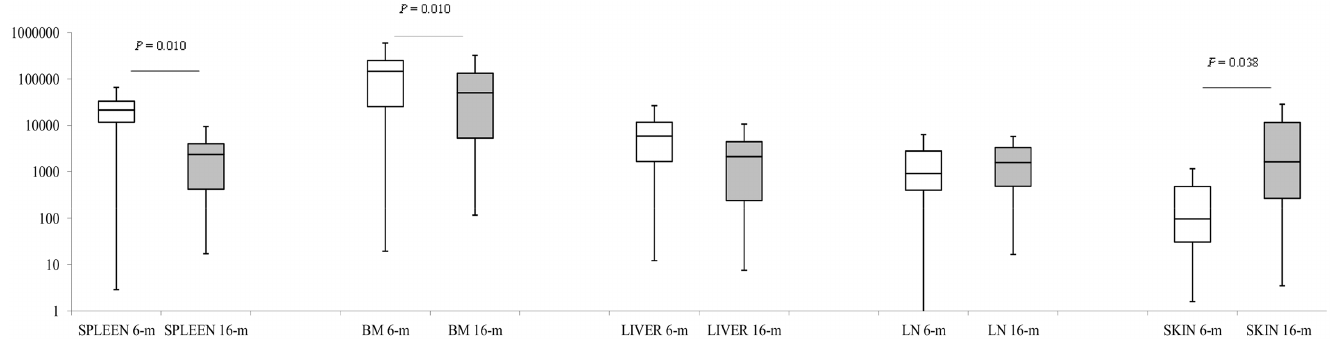
Fig 1. L . infantum parasite load detected at 6 months and 16 months post-infection in spleen, BM, liver, popliteal LN, and healthy pinna skin by real-time PCR. The number of parasites per milligram of tissue was calculated using a standard curve generated from DNA extracted from a known number of L . infantum